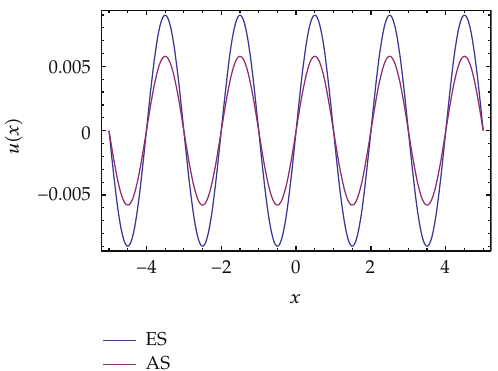
Figure 6: The compared results of the analytical and numerical solutions of Example 4.2 for t (cid:3) 1 .